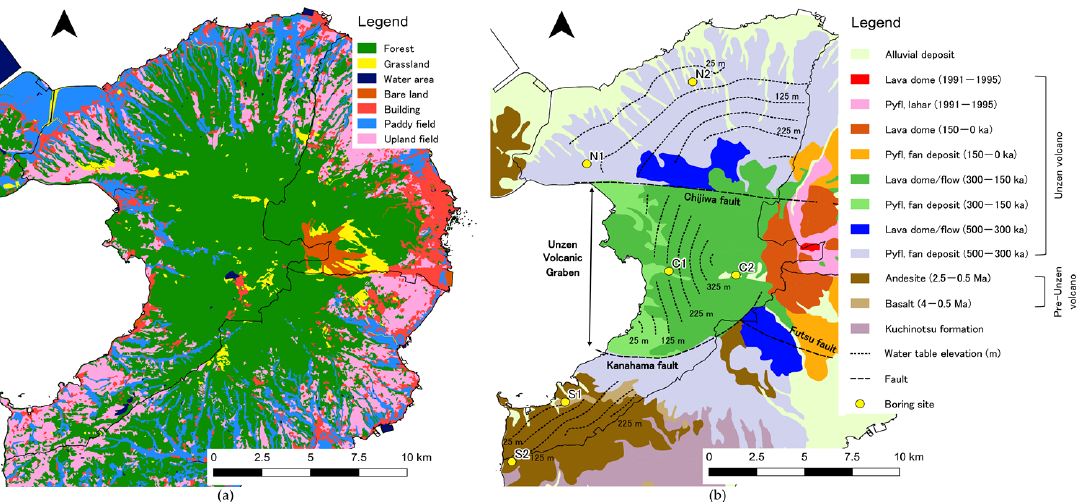
Figure 2. Land use and geology, ( a ) vegetation map, ( b ) geological map with groundwater levels and boring site; (Pyfl) Pyroclastic flow. The vegetation map is based on data collected by Biodiversity Center of Japan [25]. The geological map at 1:200,000 scale is based on data collected by Geological Survey of Japan [26].